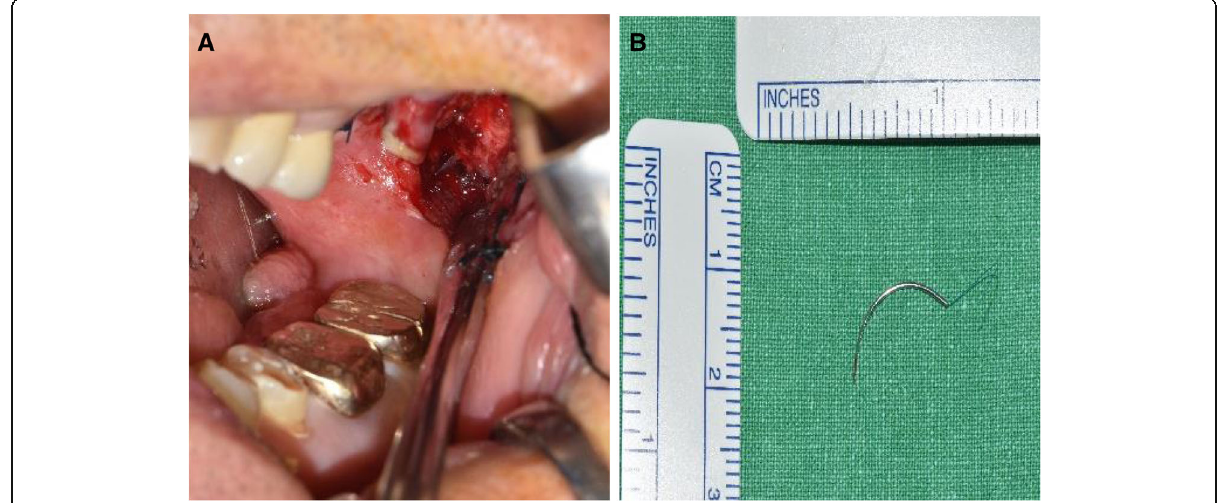
Fig. 3 A A single needle fragment embedded in the buccal mucosa. B The suture needle successfully